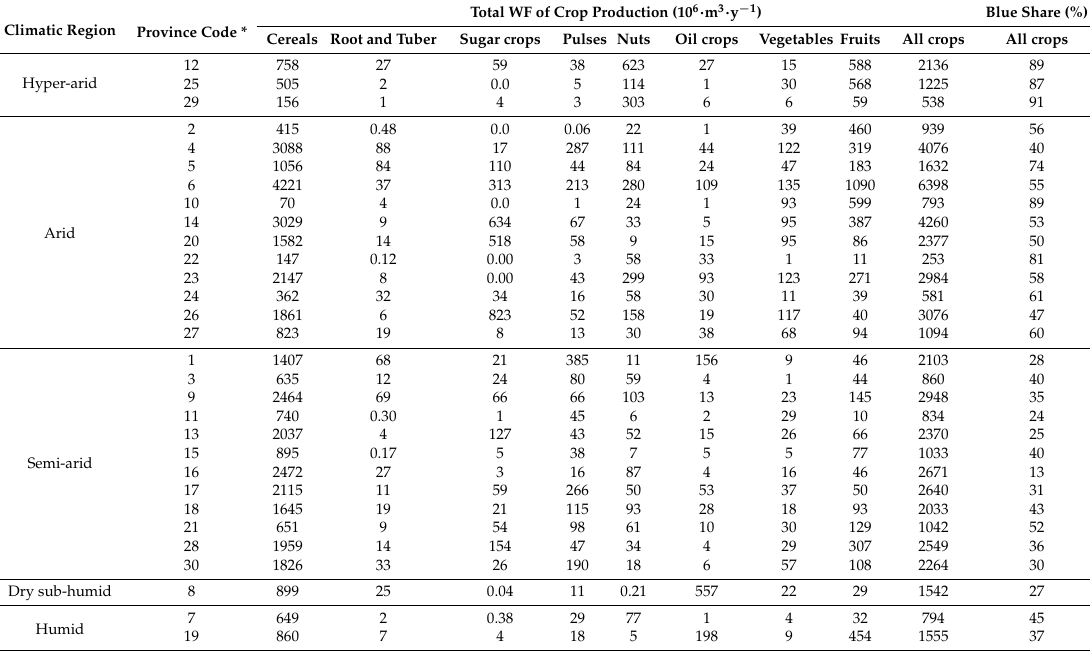
Table 2. The 30-year average total water footprint of crop production and the blue share in the total, per province and crop